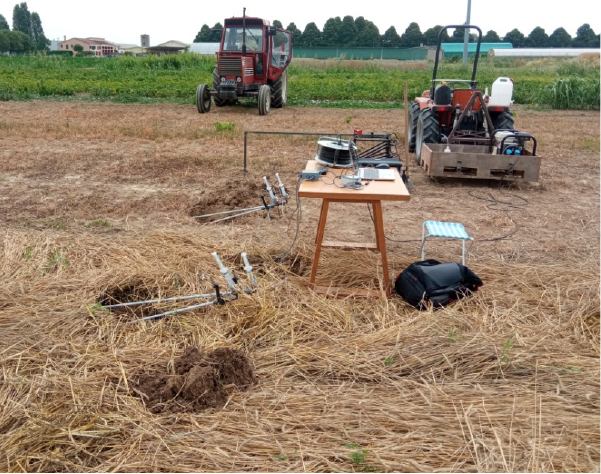
Figure 5. Installation position of the Bolling probe to measure the mean normal stress with different cover crop mulch treatments.